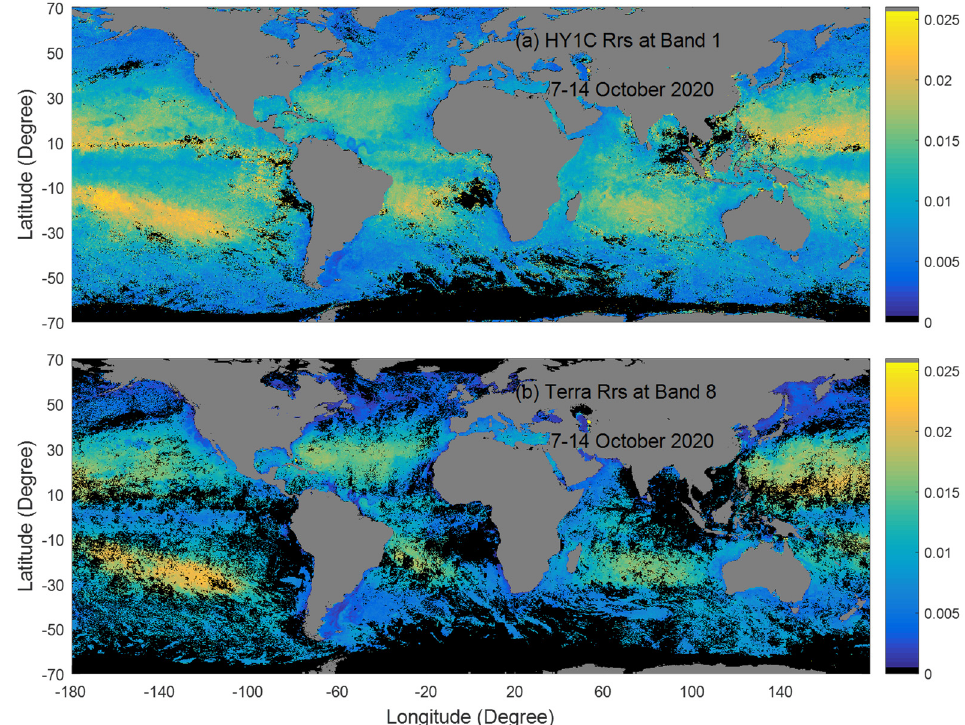
Figure 8. The comparison of the 8-day composite R rs image between COCTS/HY-1C at Band 1 ( a ) and MODIS/Terra at Band 8 ( b ). Both are produced from the global daily images during the period of 7 to 14 October 2020. The magnitudes of image pixels are indicated by the color bar with the unit of sr − 1 . Invalid pixels are masked black and land grey.